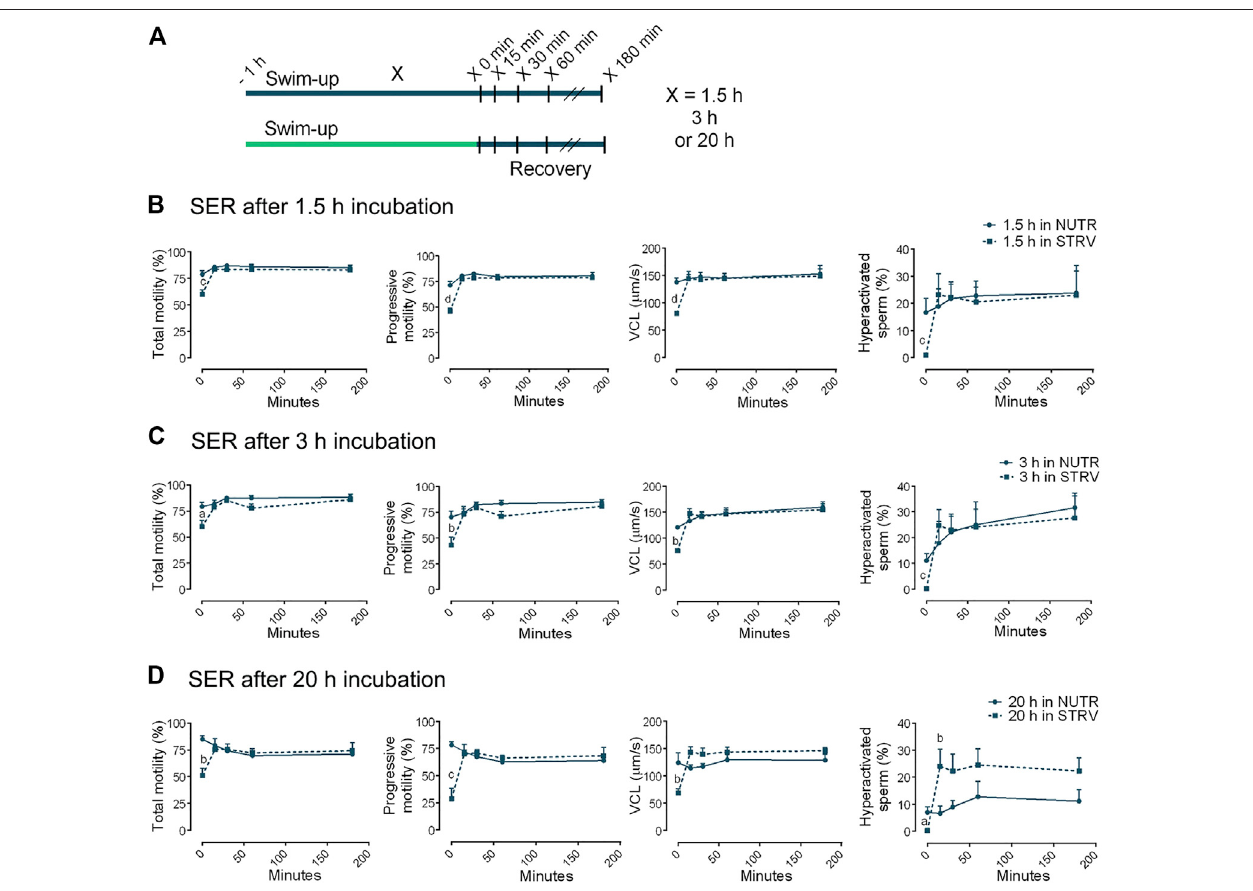
FIGURE4| Spermenergyrestrictionandrecovery(SER)treatmentafterincubationfordifferentperiodsoftime. (A) Experimentaldesign.Motilehumanspermwere selected and incubated in capacitating conditions in STRV medium for 1.5, 3 or 20 h. The energy recovery was done by adding the same volume of 2x NUTR. As a control, sperm were incubated for 1.5, 3 or 20 h in NUTR medium, and the same volume of NUTR medium was added at the time of recovery. Motility parameters were recorded by CASA before (time 0 min) and after 15, 30, 60 and 180 min of energy recovery. (B) Parameters for SER treatment after 1.5-h incubation in NUTR (full line)andSTRV (dotted line). (C) Parameters forSER treatmentafter3-hincubation inNUTR(fullline)and STRV (dotted line). (D) ParametersforSER treatment after 20-h incubationinNUTR (fullline)and STRV(dotted line).Results areexpressed asmean ± SEM, n (cid:1) 4experiments. a p < 0.05, b p < 0.01, c p < 0.001, d p < 0.001 forSTRVvs. NUTR at each corresponding time. Two-way ANOVA, and Bonferroni ’ s multiple comparison test.